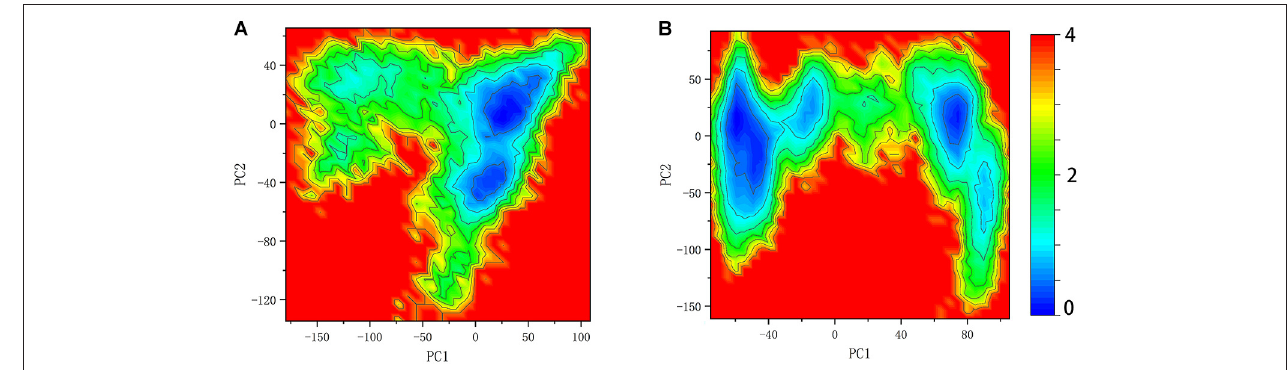
FIGURE 7 | Free energy landscape of system SHP2 (A) and DUAL (B) .